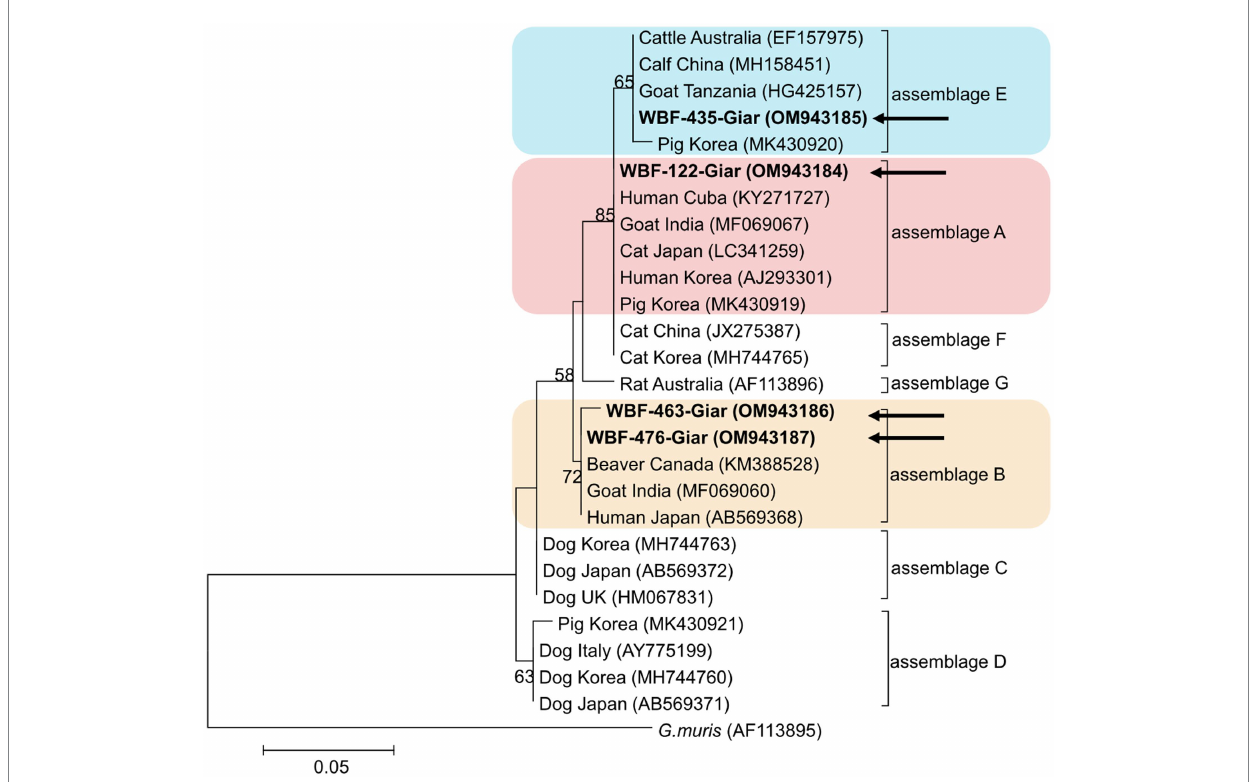
FIGURE 2 Phylogenetic tree of Giardia (18S rRNA) isolated from Korean wild boars. The sequences obtained from the phylogenetic analysis based on the Giardia 18S ribosomal RNA are indicated in bold.